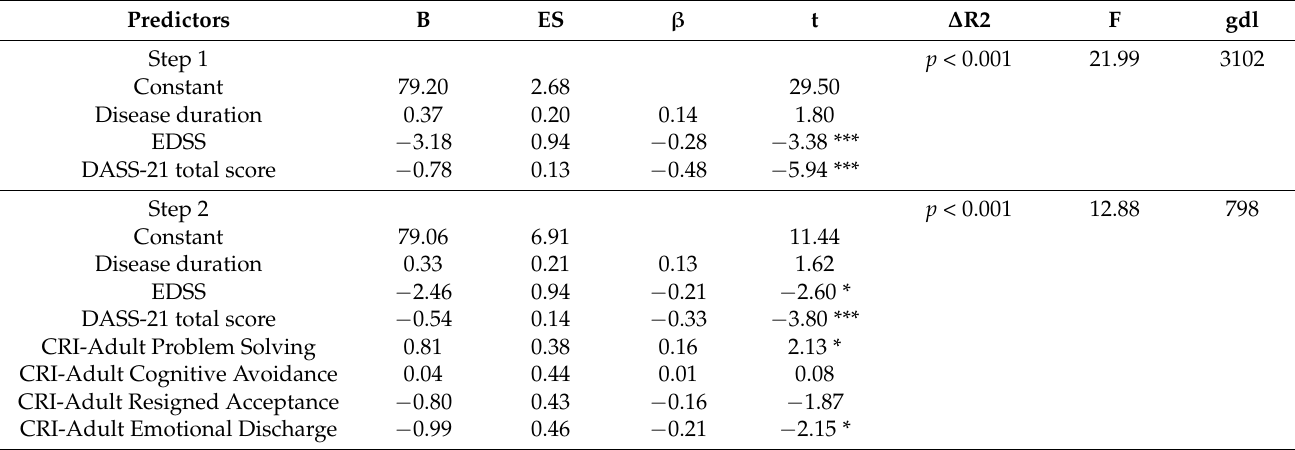
Table 3. Results of the multiple regression analysis predicting MSQoL-29 mental health composite